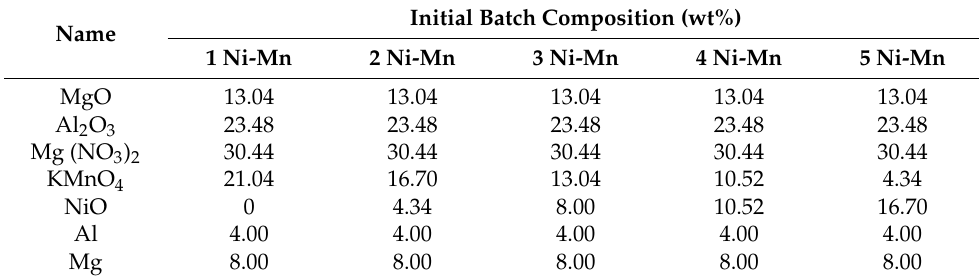
Table 1. Initial batch composition of the Ni-Mn